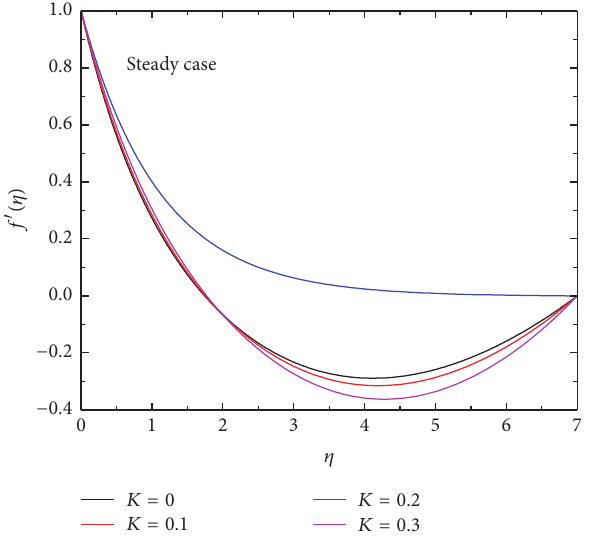
Figure 4: Temperature profiles for various values of 𝐾 when 𝐴 = 0 , 𝑅 = 0.5 , and 𝜉 = 0 .